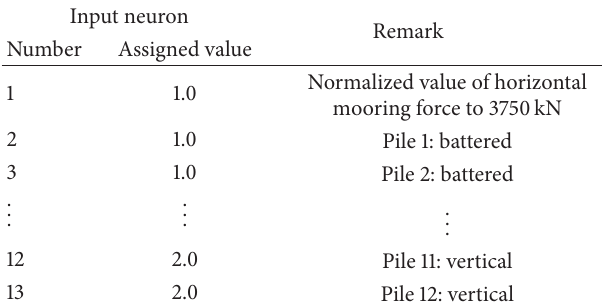
Table 5: Example of neuron inputs for neural network training